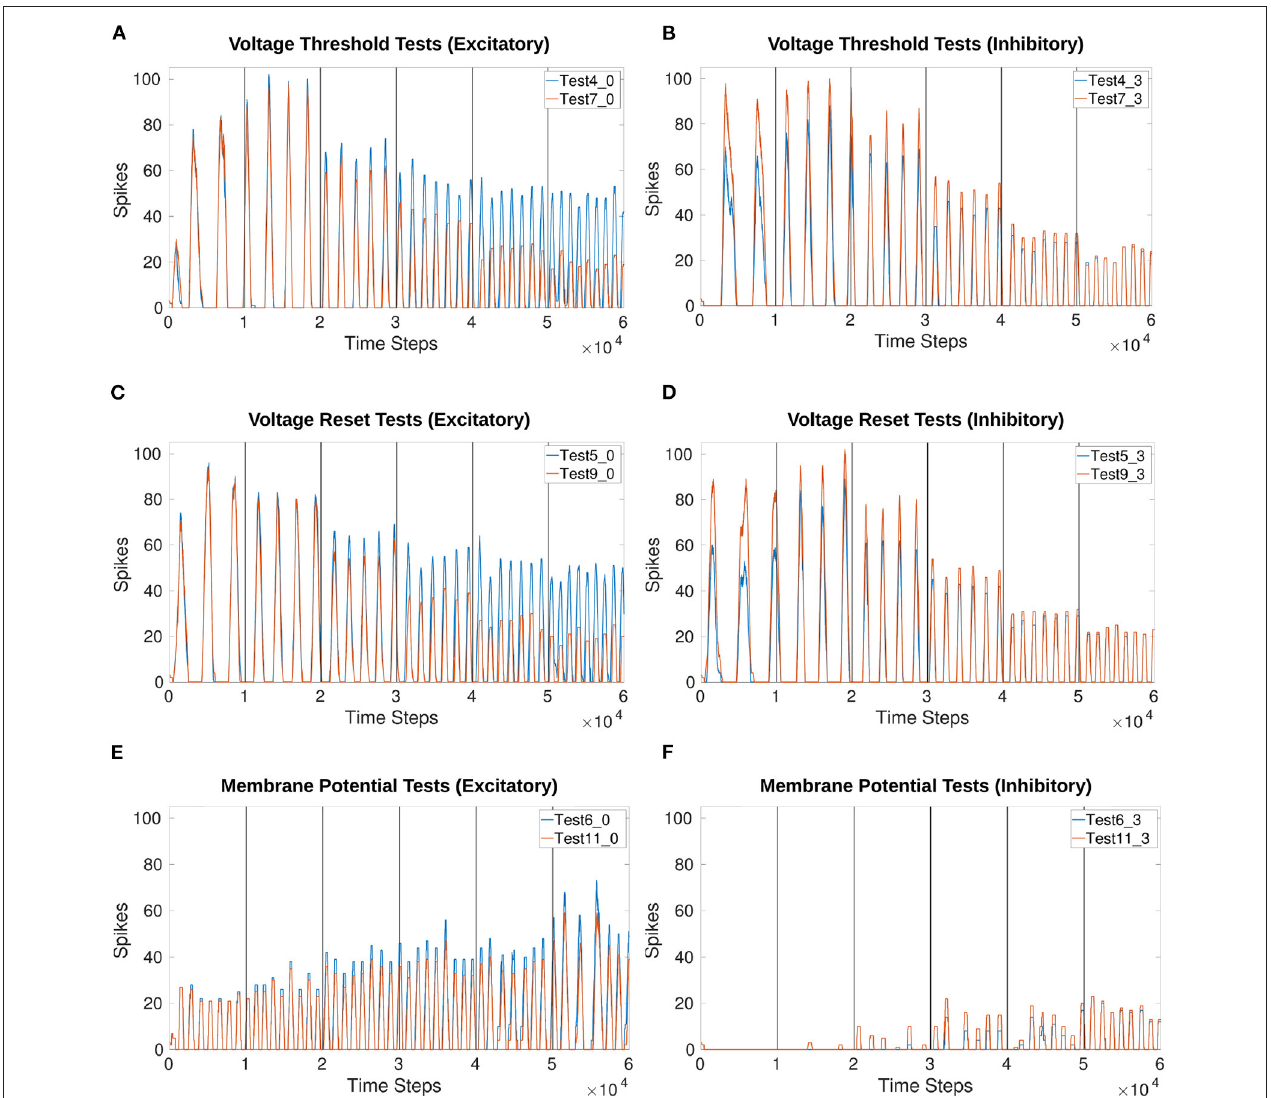
FIGURE 8 | Comparison of voltage characteristic manipulation with and without current injection to the MNP. Network behavior remains the same when current is injected to the MNP during frequency changes for all voltage characteristic manipulations. Frequency changes linearly during V th and V reset tests. Excitatory and inhibitory tests are compared to their respective counterparts. Vertical lines indicate when a change in input current occurs once per second. (A,B) Test 4 includes current injection to the MNP, Test 7 only updates voltage threshold potential; (C,D) Test 5 includes current injection to the MNP, Test 9 only updates voltage reset; (E,F) Test 6 includes current injection to the MNP, Test 11 only updates membrane potential. See Tables 1 , 2 and Figures 4 , 5 for setup and details per test